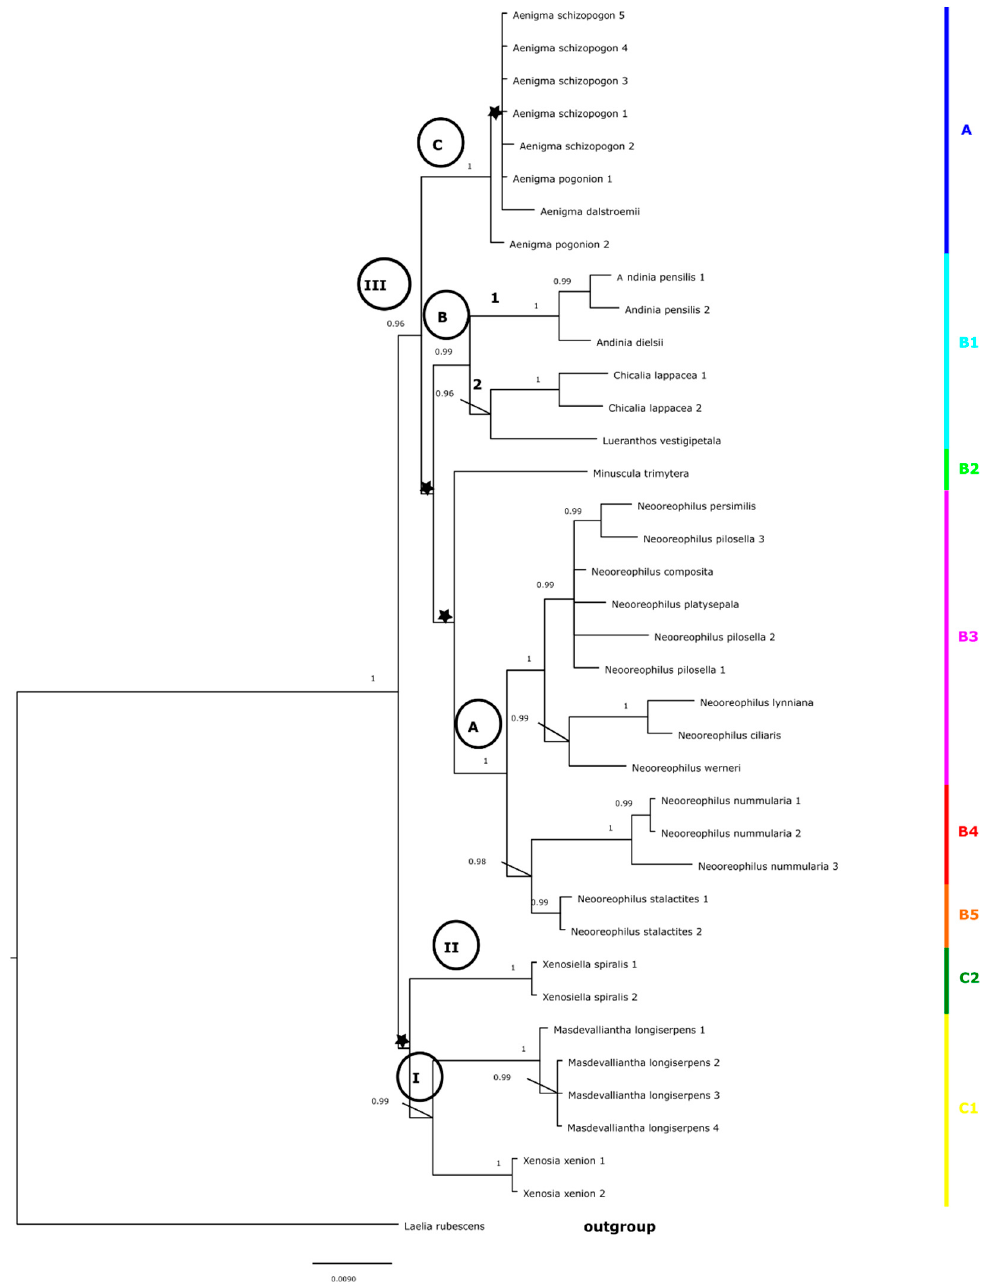
Figure 6. Majority-rule consensus tree for Andinia s.l. obtained in Bayesian analysis from combined matrix (ITS + mat K). Values above branches represent posteriori probabilities; values with pp < 0.9 are indicated with an asterisk. The main and strong supported clades on the tree are marked with the numbers I–III. The subclades are tagged as capitals A–C. Discussed groups of species are marked as A–C2.